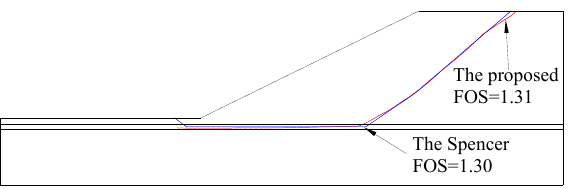
Figure 14. Critical slip surfaces based on wavelet packet and Spencer for Example 2.